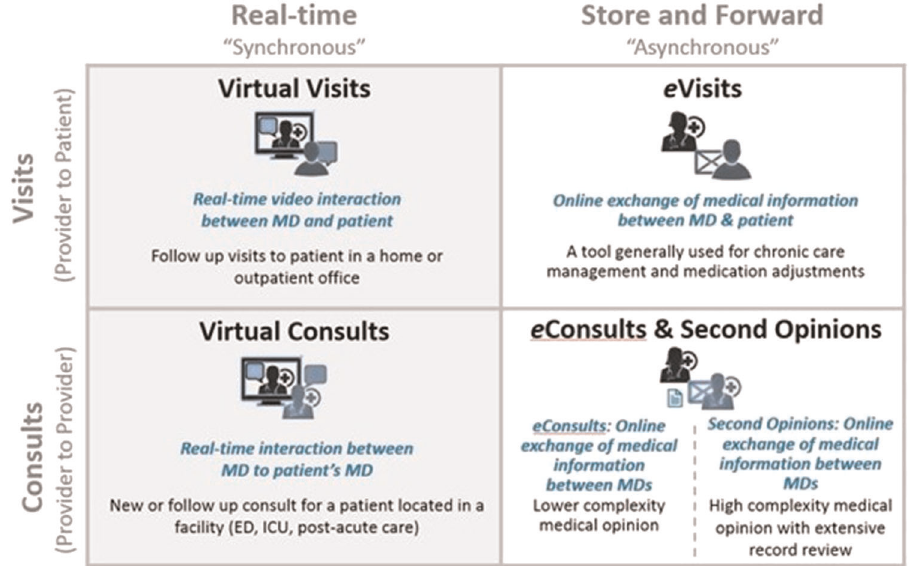
Fig. 1 Virtual care programs at Partners Healthcare. Virtual care programs deployed at Partners Healthcare, classi fi ed by the modality of communication (synchornous vs asynchronous) and type of participants. The Virtual Visits program depicts a realtime video interaction between a provider and patient; the Virtual Consults program depicts a realtime video interaction between a referring provider and the expert teleconsultant; the eVisits program depicts a secure text-based exchange between a provider and patient; and the eConsult & Second Opinions programs depict two levels of secure text and image-based exchange between a referring provider and the expert teleconsultant, with eConsults being low complexity simple questions and Online Second Opinions being full formal consultations regarding high complexty problems and extensive records or